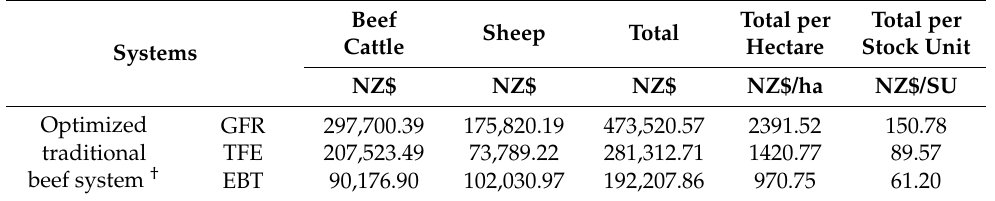
Table 4. Total, per hectare, and per stock unit values of the gross farm revenue (GFR), total farm expenditure (TFE), and farm earnings before tax (EBT) of beef cattle and sheep activity for the opti- mized system, Scenario I and Scenario II.